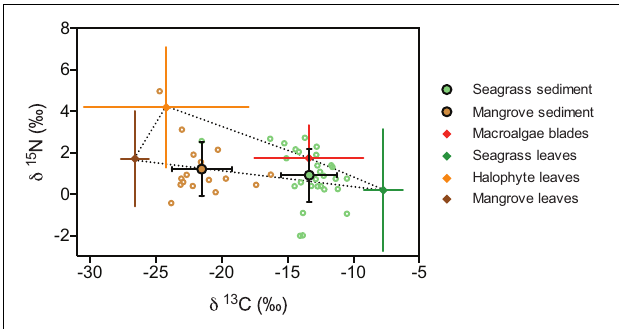
FIGURE 7 | Iso-space plot showing mean ( ± SD) δ 13 C and δ 15 N values of seagrass and mangrove sediments (green and brown circles, respectively) and potential sources contributing to their accumulated organic matter (color coded diamonds). For seagrass and mangrove sediments all data points are shown (green and brown open circles, respectively). Bars indicate standard deviation used in the input of Bayesian mixing models. Dotted line shows the convex hull defined by potential